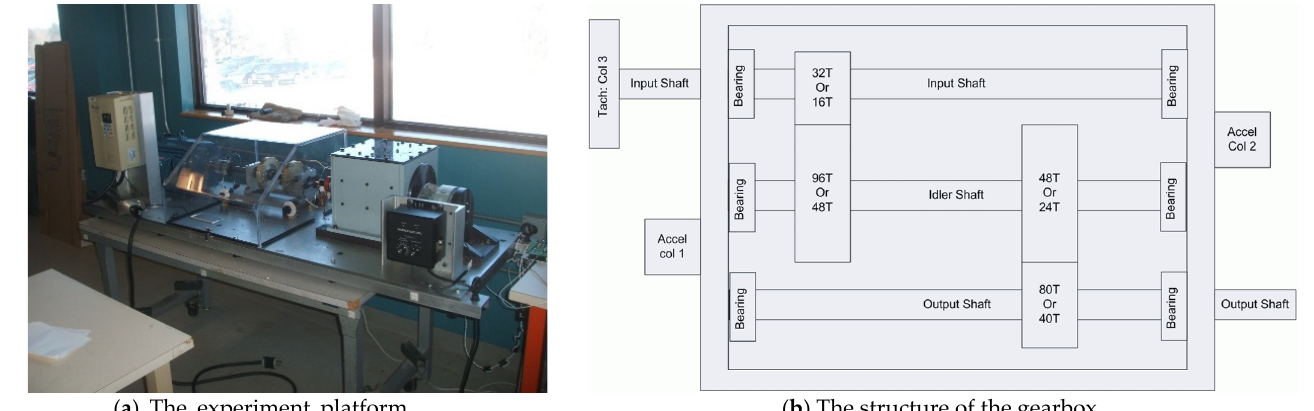
Figure 7. The experimental platform and gearbox structure.